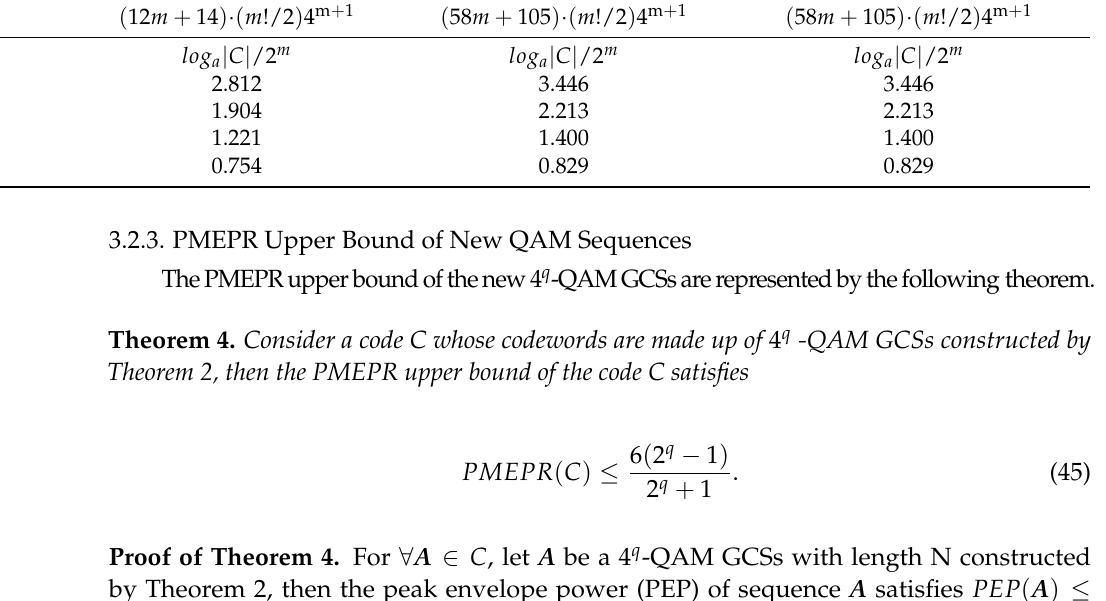
between [23] and this pa- 𝑞𝑞 = 2 . 𝑞𝑞 = 2